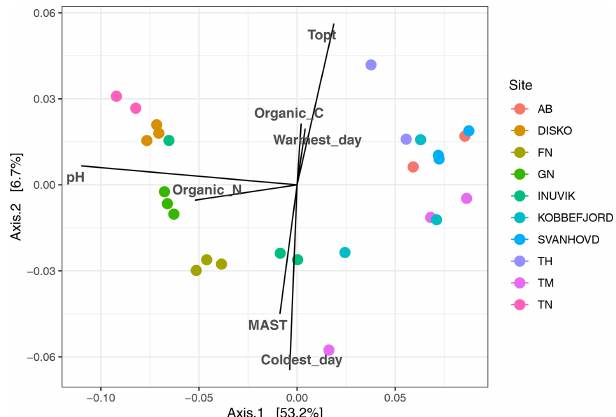
Figure 5. Principal coordinate analysis of bacterial community composition (16s rRNA amplicon sequencing), based on weighted UniFrac distances with the correlation of measured environmental factors.